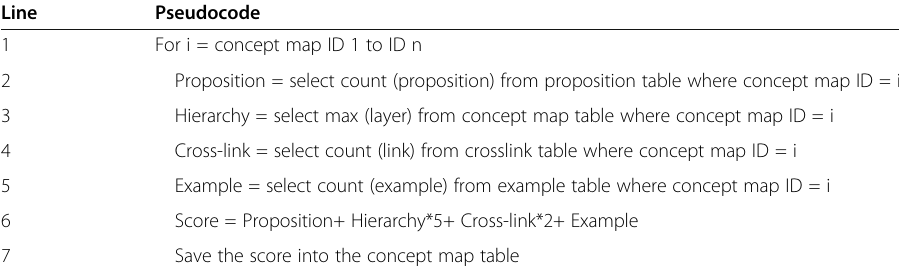
Table 2 Pseudocodes for concept map structure evaluation